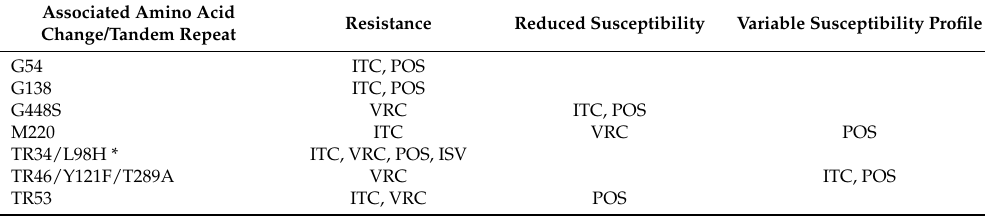
Table 1. Expected azole susceptibility profiles with respect to the detected resistance